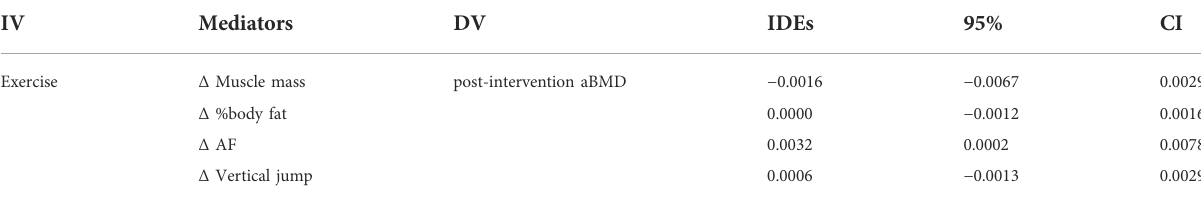
TABLE 5 Mediated analysis of the relationship between exercise and post-intervention